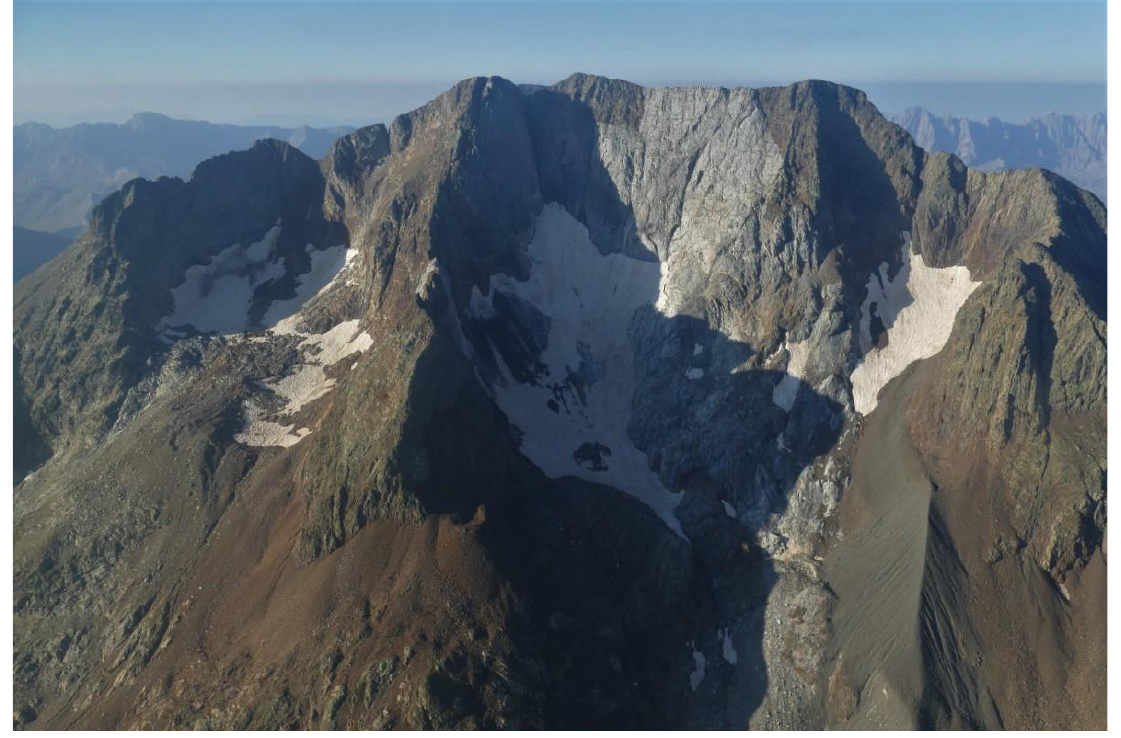
Figure 2. View of the Infierno Massif, northeastern face. Infierno Glacier (central position), former eastern glacier (left) and former western glacier (right), now dead ice-snow patches. September 20, 2018. This glacier is now a small mass of ice that has experienced a significant shrinkage: from 40 ha in the Little Ice Age to 14 ha in 1980 [16]. Since this date, the shrinkage has continued at an accelerated rate, reaching just 5.52 ha at the end of the summer of 2022, between 2929 m a.s.l. and 2698 m a.s.l. elevations, with an average slope value close to